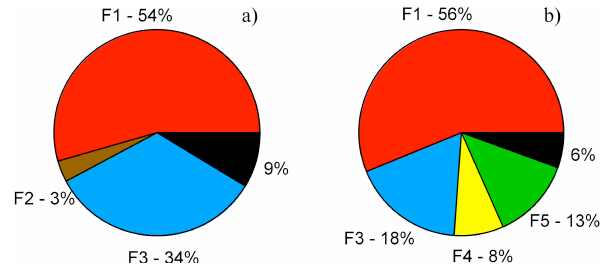
Fig. 7. PMF results on the 2007 average distribution of A 365 amongst (a) the four factors resolved for all FRM sites (rural and urban) using a limited suite of species, and (b) the five factors re- solved for only urban speciation sites listed in Table 1. The fac- tors were identified (Zhang et al., 2010a) as, F1: Biomass Burn- ing, F2: Refractory Material, F3: WSOC/Oxalate, F4: Ammonium Sulfate/WSOC, F5: Mobile Sources, remaining is the unresolved fraction.